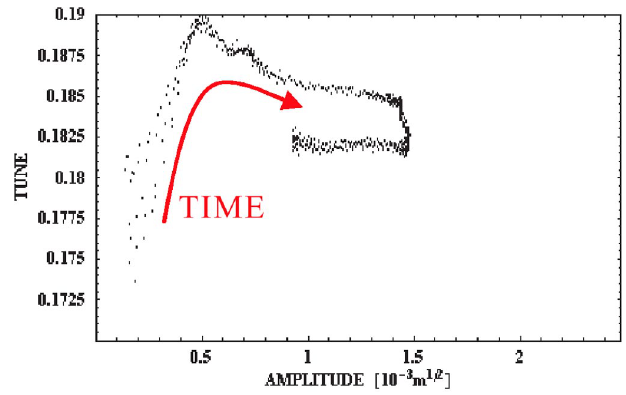
FIG. 23. (Color) Tune versus normalized oscillation amplitude at the tail of the LHC bunch train in the SPS for a bunch population of 1 : 1 (cid:1) 10 11 [35]; the data for the first 700 turns after injection are plotted; each data point represents a sliding- window average over 32 successive turns of the amplitude and phase advance per turn.